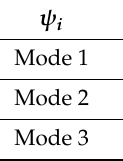
Table 4. Buckling modes ( ψ i ) and buckling load multipliers ( λ i ) .